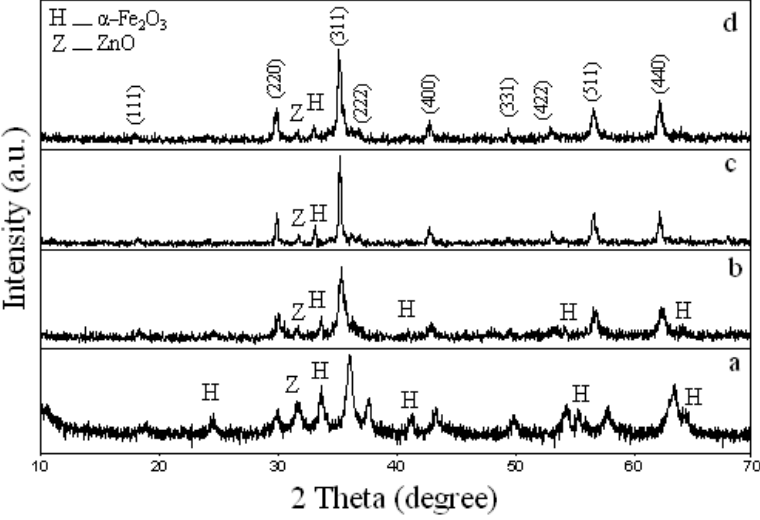
Figure 3. XRD patterns of zinc ferrite nanoparicles with concentration of ( a ) 0, ( b ) 15, ( c ) 40, and ( d ) 55 g/L which calcined at 873